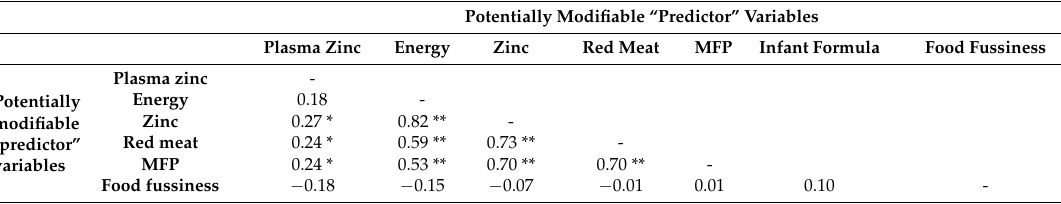
Table 4. Correlations (r) between potentially modifiable “predictor” variables, and between these continuous variables and plasma zinc concentration.